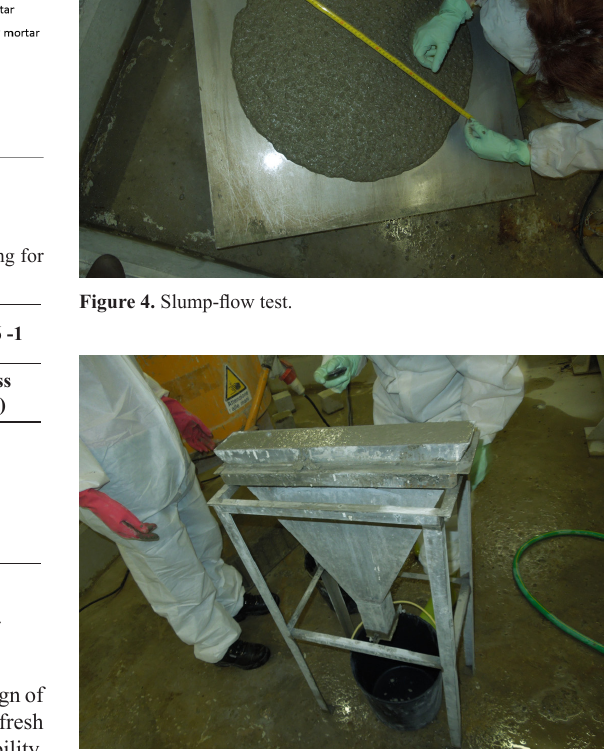
Figure 5. V-funnel